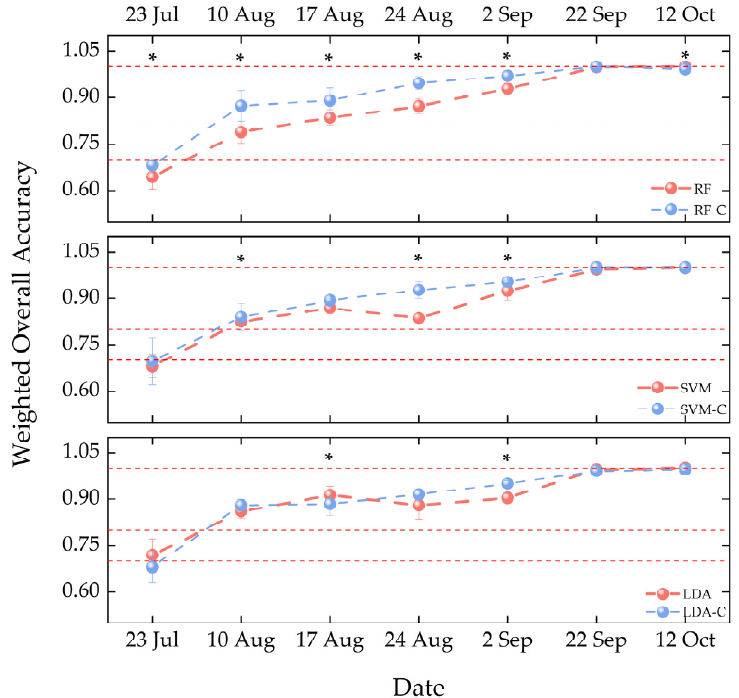
Figure 6. Temporal variation in classification accuracy of infected trees (the red discontinuous line from bottom to top represents that WO is 0.7, 0.8, 1.0). The classifications (RF, SVM and LDA) were performed using the basic values and the difference values (indicated by C). RF: random forest; SVM: support vector machine; LDA: linear discriminant analysis. The symbol * indicates significant differences ( p < 0.05).